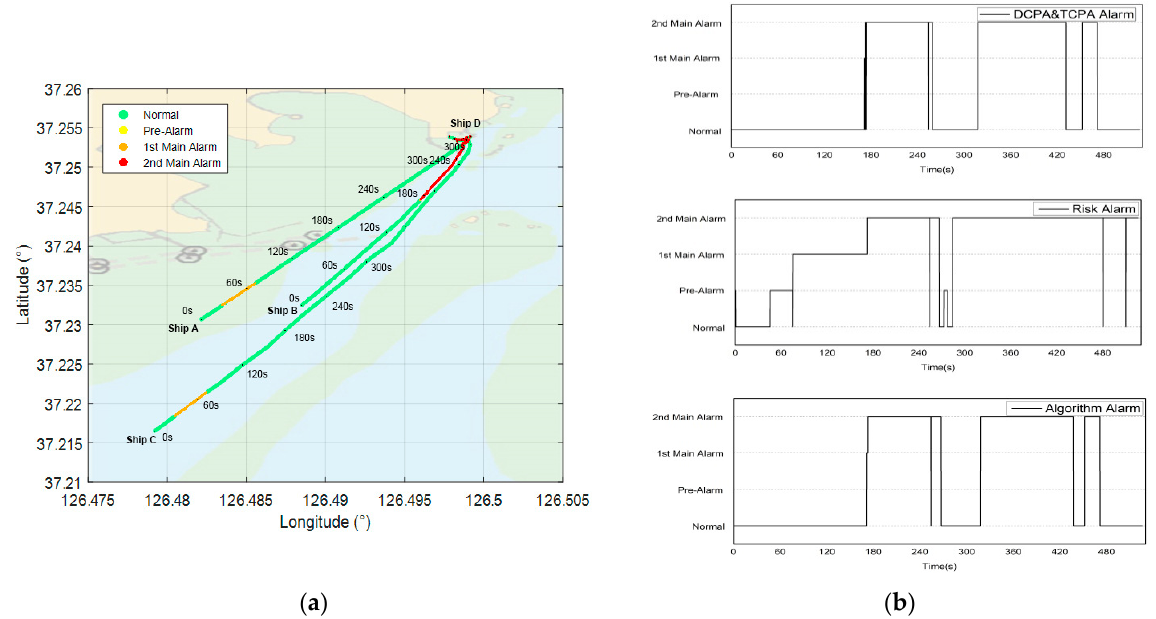
Figure 9. ( a ) Diagrammatic representation of the track of the alarms generated from the results of case 2 and ( b ) graphical representation of the alarms generated on ship B depending on the time (from the top, the alarms based only on DCPA and TCPA criteria, alarms based only on the PARK model risk value criterion, and alarms based on the algorithm). Table 6. Analysis of the situation of alarm generation on ship B in case 2.